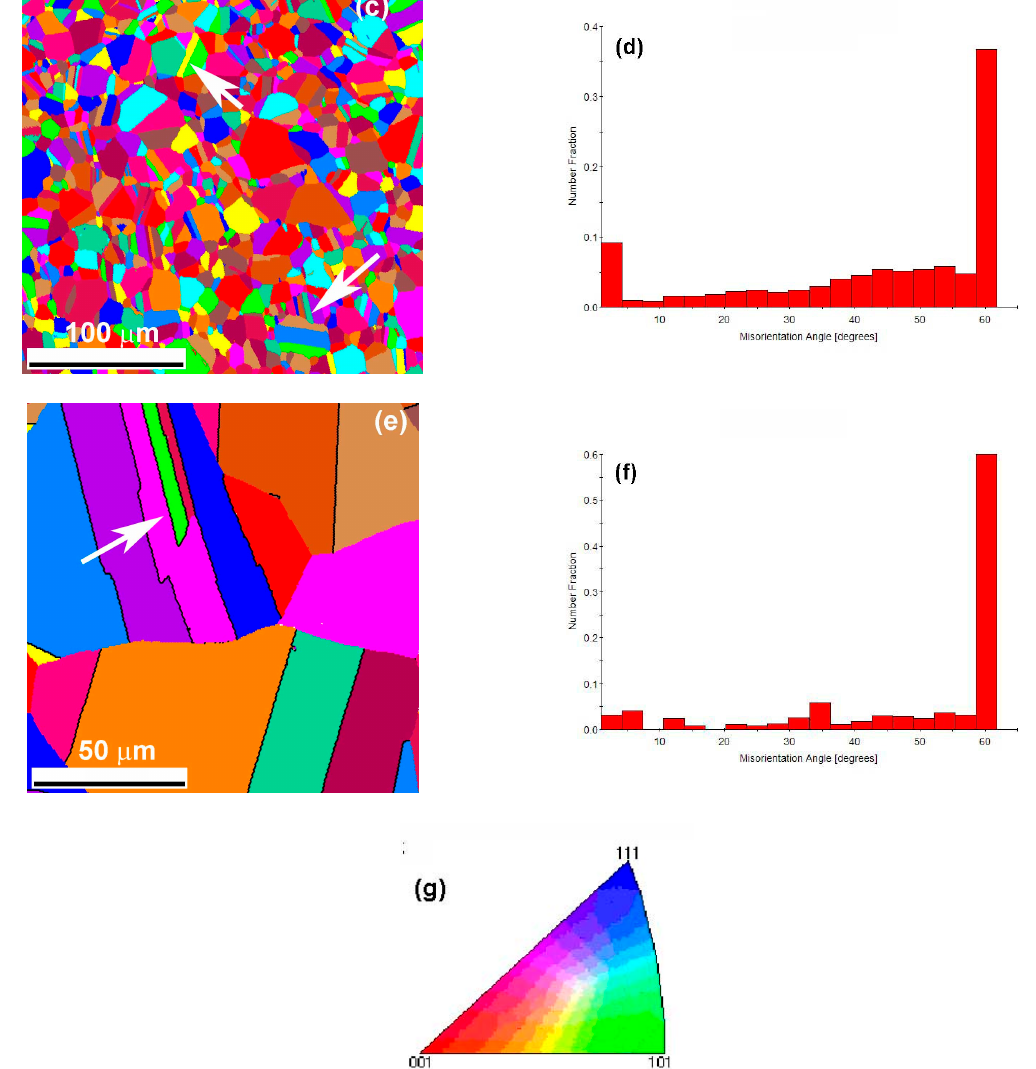
Figure 5. Unique grain color maps ( a , c , e ) and corresponding misorientation angle charts ( b , d , f ) acquired from the Cu-77 wt.% Ni alloy after HPT and subsequent annealing at ( a , b ) 600 ◦ C, 3 h; ( c , d ) 750 ◦ C, 2 h; and ( e , f ) 900 ◦ C, 1 h. Step size in all cases 500 nm. In Figure 5c, the distribution of CSL Σ 3 boundaries is clearly visible. Two Σ 3 GBs (flat twins) are shown by arrows. ( g ) Color indexing orientation triangle.